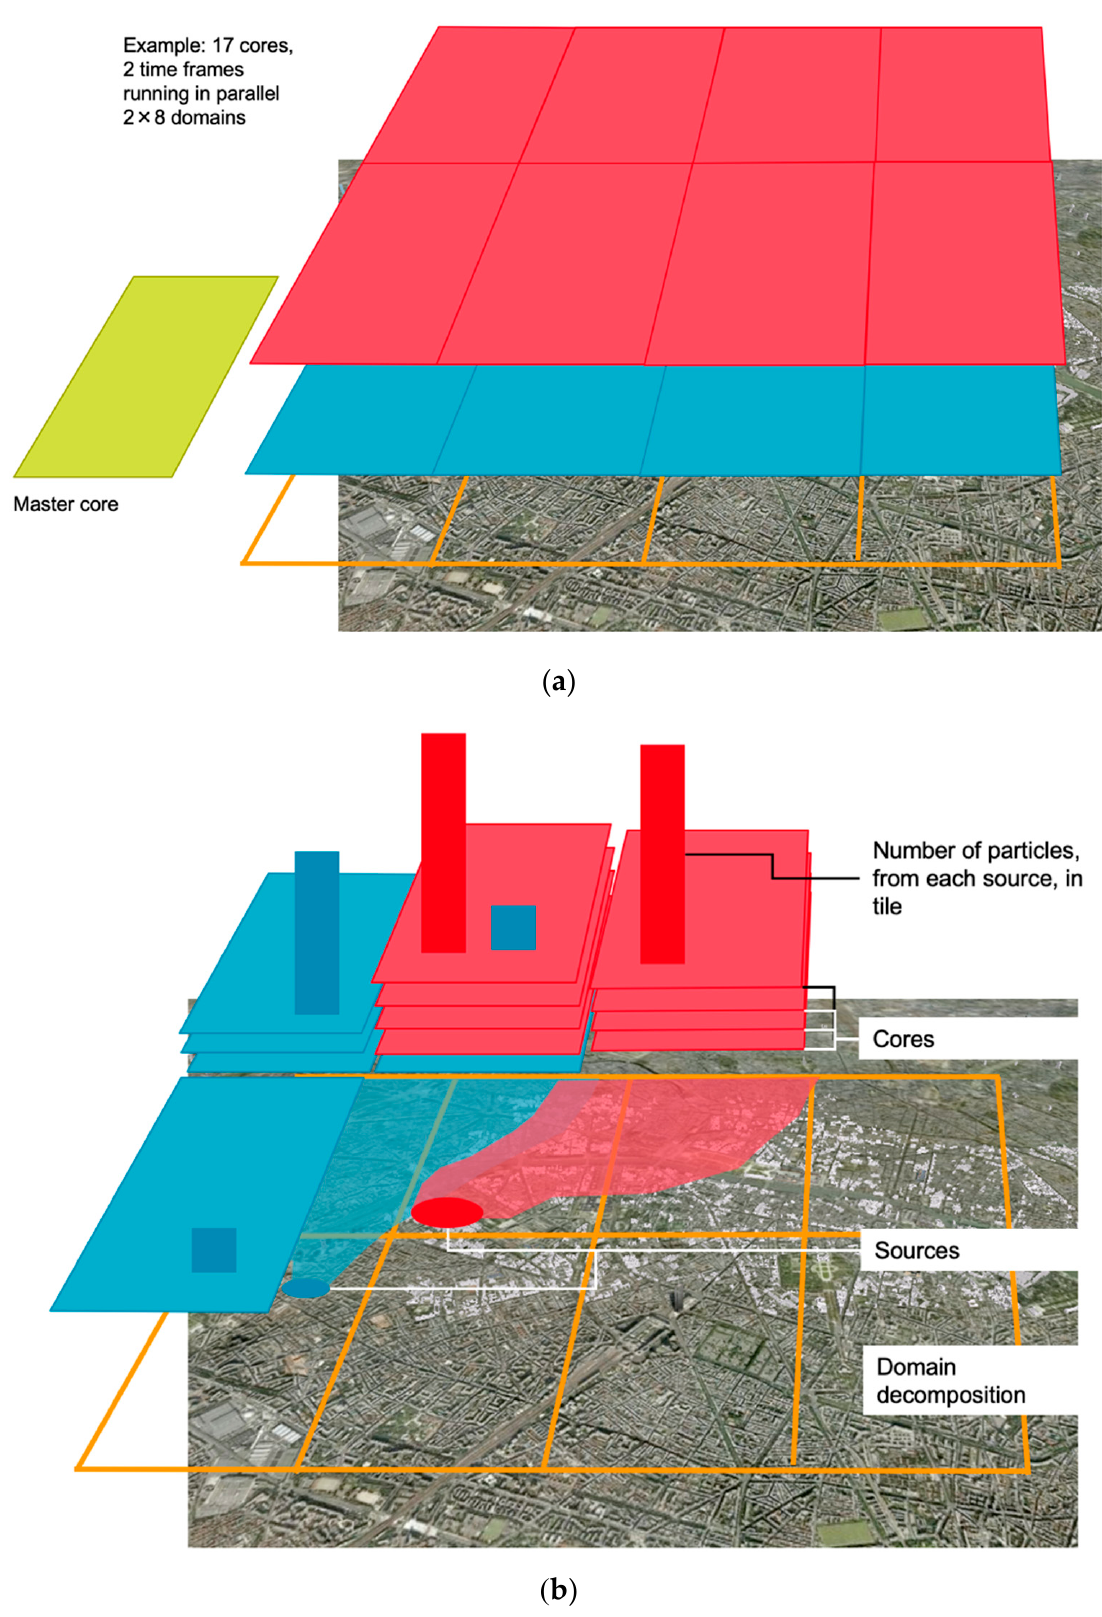
Figure 1. Example of parallel settings: ( a ) domain decomposition and time frame parallel treatment for the PSWIFT model using 17 cores on a domain decomposed into 8 tiles; ( b ) domain decomposition and particle distribution for the PSPRAY model.